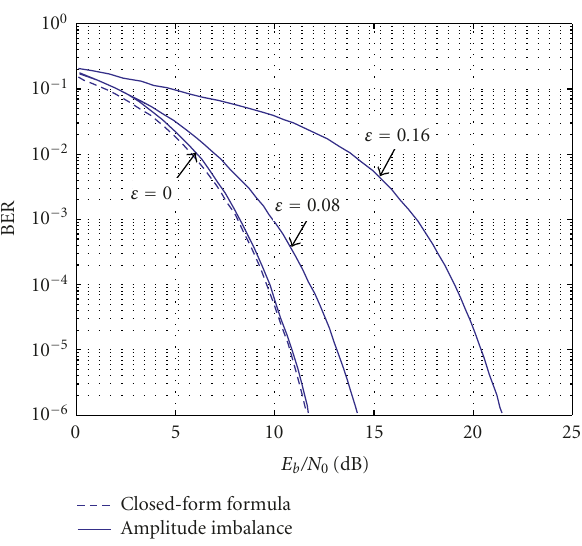
Figure 12: Conversion gain versus RF frequency for I and Q chan- nels at LO power of 10 dBm.